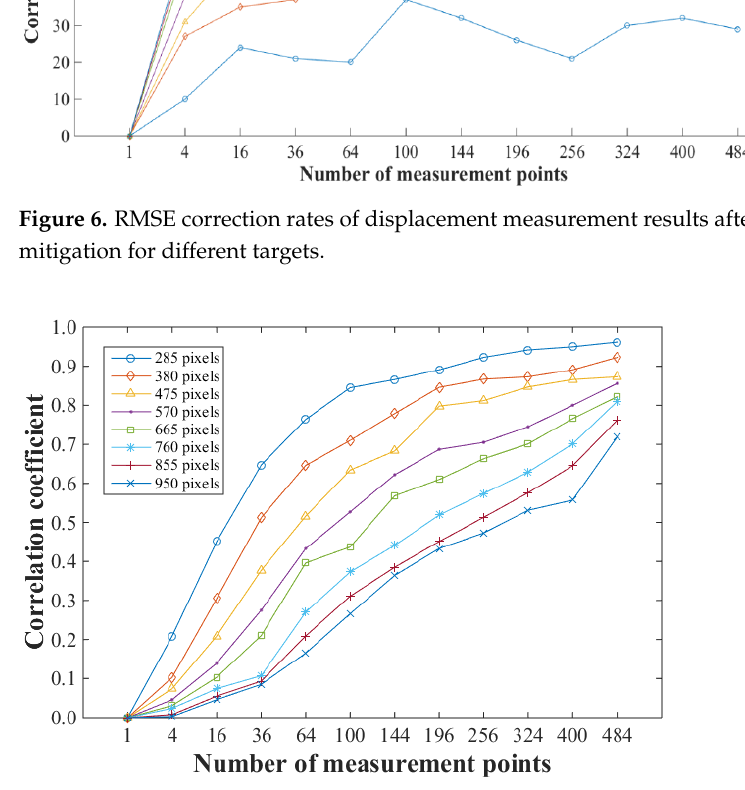
Figure 8. Execution time of optical-turbulence error mitigation for different targets. Combining the above results, the RMSE of the displacement measurement results after mitigating the optical-turbulence error is not significantly reduced when the target size is 285 and 380 pixels. Analyzing Figure 7 reveals that the correlation coefficients for targets with 285 and 380 pixel sizes are higher than the larger target size, and thus using the proposed method is less effective in mitigating the optical-turbulence error. As the target size increases, the RMSE of the displacement measurement results after mitigating the optical-turbulence error tends to decrease, and there is a certain improvement in the effect of mitigating the optical-turbulence error using the proposed method. The correla- tion coefficient shows that the correlation decreases as the target size increases, so the measurement points at different locations on the target can be fully utilized to mitigate the optical-turbulence error. However, the RMSE of the displacement measurement